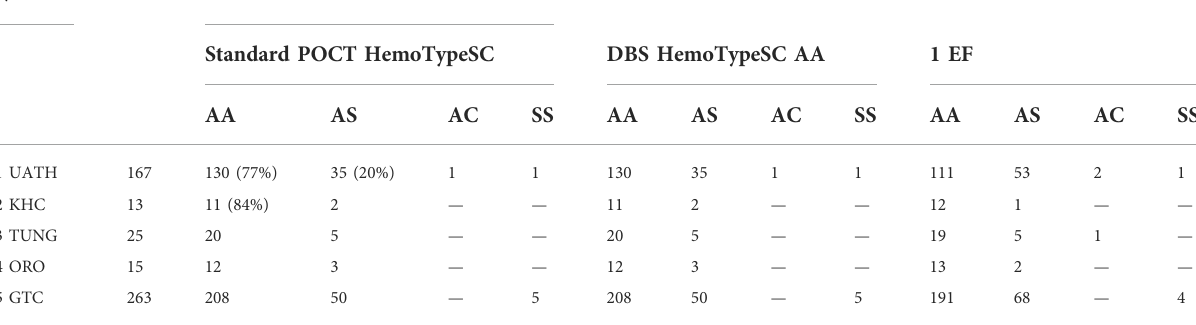
TABLE 1 Genotype and allele frequencies identi fi ed by HemoTypeSC and IEF in the 6 centers comprising University of Abuja Teaching Hospital immunization centers attached to